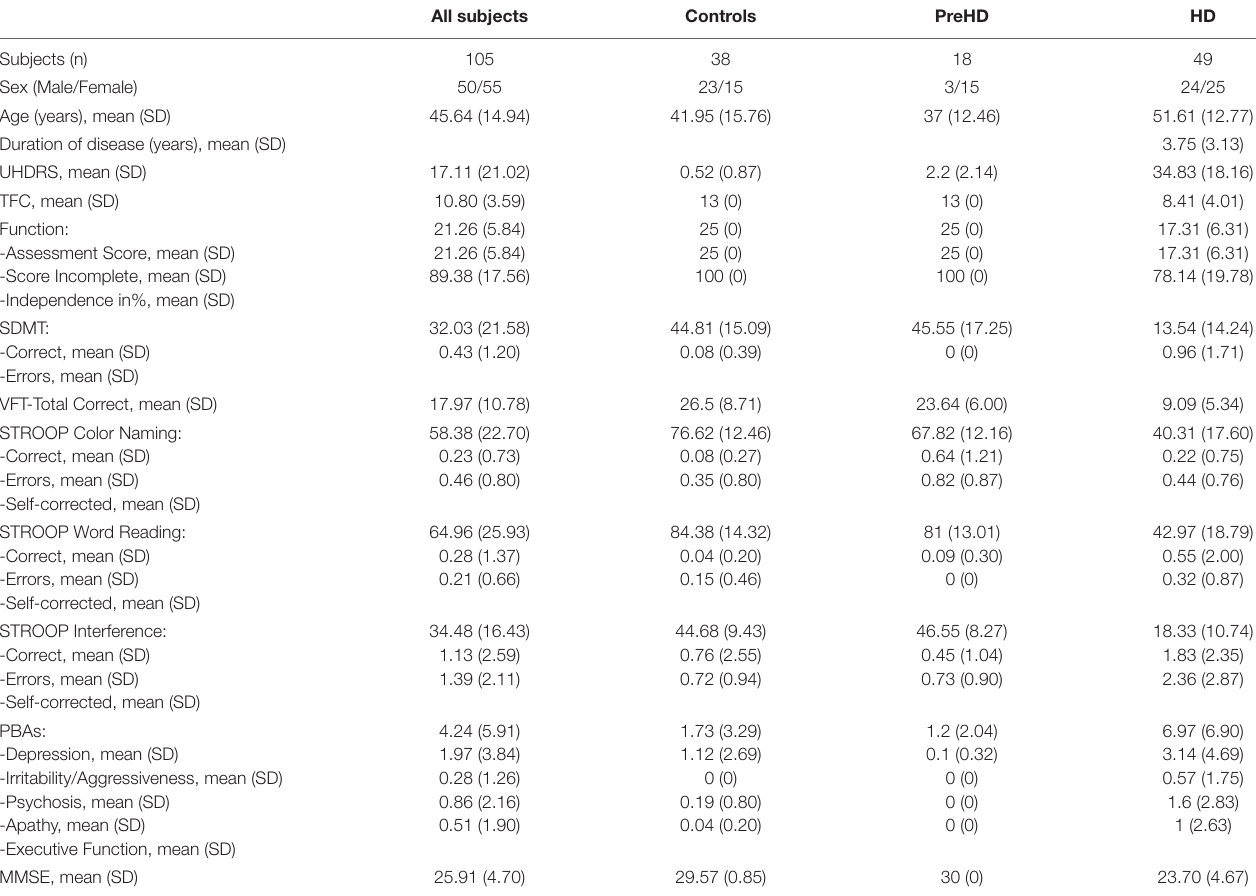
TABLE 1 | Demographic and clinical features of the 105 subjects included in the study sample.